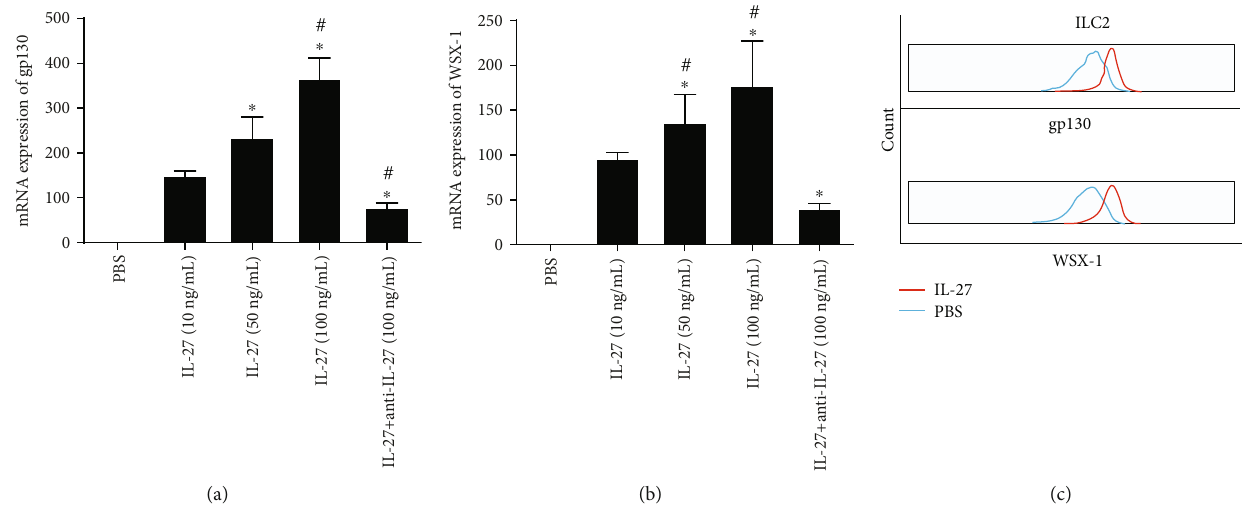
Figure 3: The IL-27 receptor expression by ILC2 regulated by IL-27. (a, b) The mRNA expression of gp130 and WSX-1 by ILC2 after IL-27 stimulation by polymerase chain reaction. (c) The protein expression of gp130 and WSX-1 by ILC2 after IL-27 stimulation by fl ow cytometry. Three independent tests were performed for every experiment. ∗ Compared with IL-27 (10 ng/mL), P < 0 : 05 . # Compared with IL-27 (50 ng/mL), P < 0 : 05 . gp130: glycoprotein 130; ILC2: group II innate lymphoid proportion of ILC2 ( r = − 0 : 52 , P < 0 : 01 ) and TNSS score ( r = − 0 : 53 , P < 0 : 01 ) (Figures 2(a) and 2(b)), whereas the pro- portion of ILC2 was positively correlated with TNSS score ( r = 0 : 57 , P < 0 : 01 ) (Figure 2(c)).